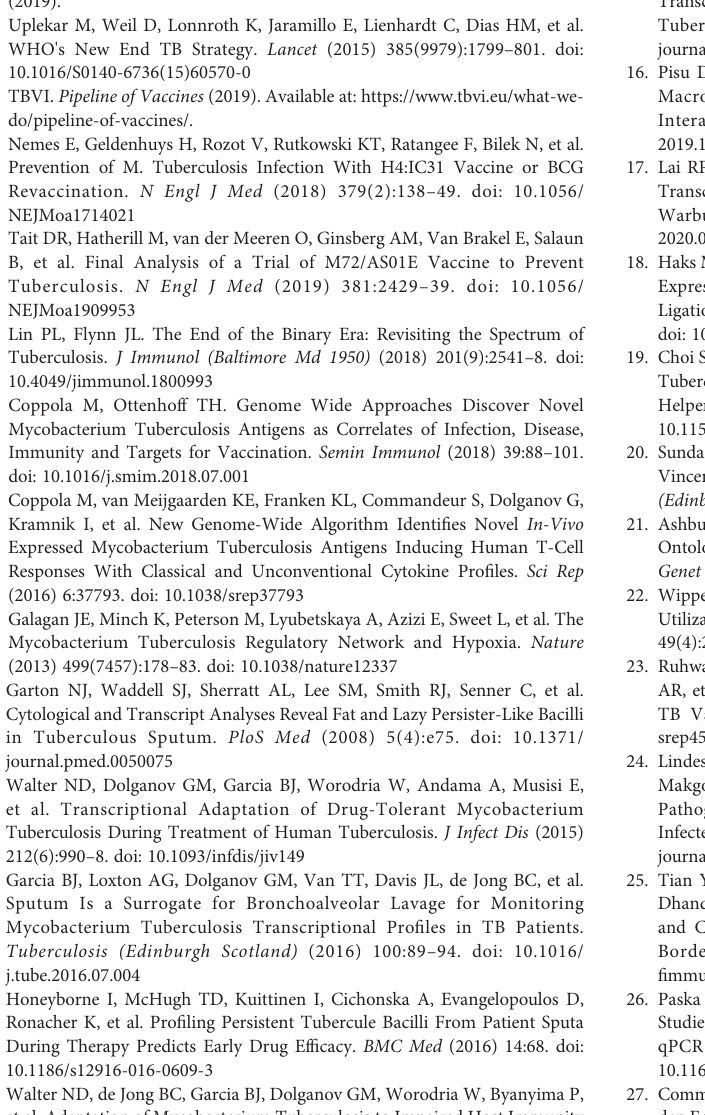
Mtb infected C57BL/6J mice (S1.6) (GEO: GSE132354) (16); human sputa (S1.2, S1.3, S1.5 and S1.7) (11, 12) (GSE137518); in BAL samples (S1.3) (12) from TB patients as well as under in vitro conditions (S1.4). If not performed previously, a quantile normalization was performed on raw data of interest (for data in S1.5). Within each dataset, genes were ranked from zero to 100, with zero and 100 representing respectively the lowest or undetected (only for the RNA-Seq data) genes and the most highly expressed gene. The median rank was calculated for each gene among samples. Table S1.8 reports the top expressed Mtb genes in common among the human RT-PCR datasets only. Table S1.9 reports the overlap between the top ranked Mtb genes of the two different experimental models with the top ranked Mtb genes of the in vivo RT-PCR datasets. Table S1.10 lists the 17 Mtb transcripts overlapping with the top ranked genes found in our C3HeB/FeJ “ Kramnik ” dataset (8) and a previous published comparative analysis between Mtb transcriptomes from susceptible(I/StSnEgYCit) and resistant (C57BL/6YCit) mouse strains